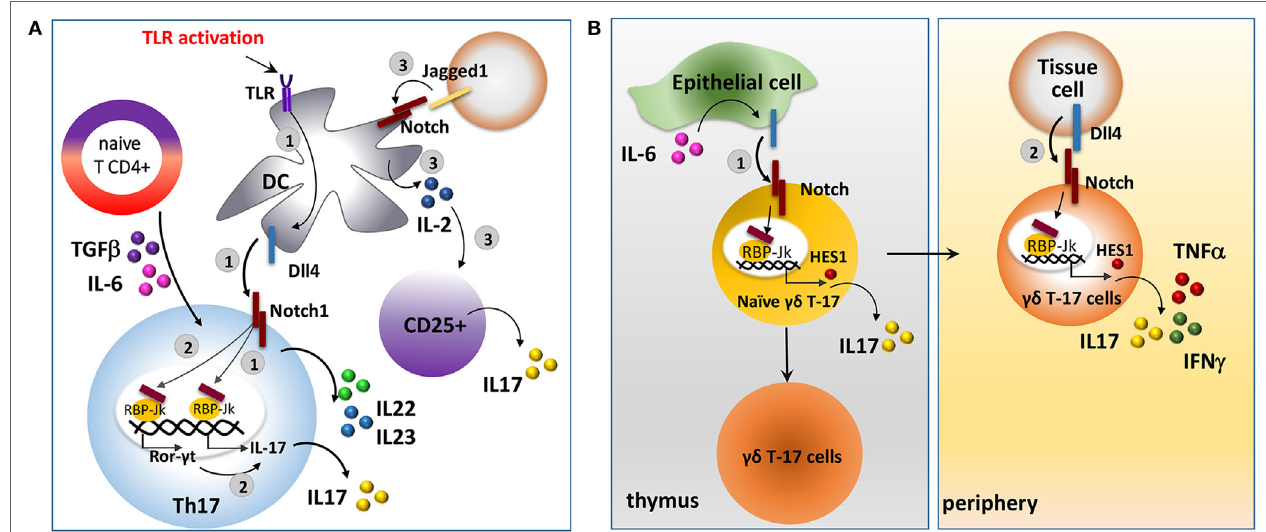
FiGURe 4 | The interaction between Notch and interleukin 17 (IL-17) in different immune cellular settings. (a) Notch signaling stimulates Th17 cell differentiation. 1. Dll4, upregulated on DC cells upon TLR activation, in cooperation with skewing cytokines, IL-6 and transforming growth factor- β (TGF- β ), activates Notch signaling in naive CD4 + T cells inducing the production of IL-17 and Th17-related cytokines, IL-22 and IL-23, and the consequent differentiation in Th17 cells. Dll4-mediated Notch activation in naive CD4 + T cells results in the direct transactivation of IL-17 promoter by activating the RBP-Jk/CSL transcription factor (163–165). 2. In addition, ICN may also stimulate Th17 cell differentiation by transactivating the promoter of Ror- γ t, a transcription factor required for Th17 differentiation and a main regulator of IL-17. 3. Jagged1-conditioned DCs produce IL-2 that is required for the production of IL-17 by CD25 + cells (166). (b) Notch signaling in γδ T-17 cells. 1. Dll4, upregulated on thymic epithelial cells following IL-6 induction, activates Notch signaling in γδ T-17 cells resulting in expression of HES1, that in turn induces the production of IL-17 and the development of γδ T-17 cells (28, 167). 2. High level of Dll4 in peripheral tissues, such as the intestine and lung, is enable to activate Notch in γδ T-17 cells (28). This results in the production of IL-17, IFN- γ , and tumor necrosis factor α (TNF α ) along with the proliferation and activation of peripheral γδ T-17 cells and enhancement of their antitumor cytolytic effect